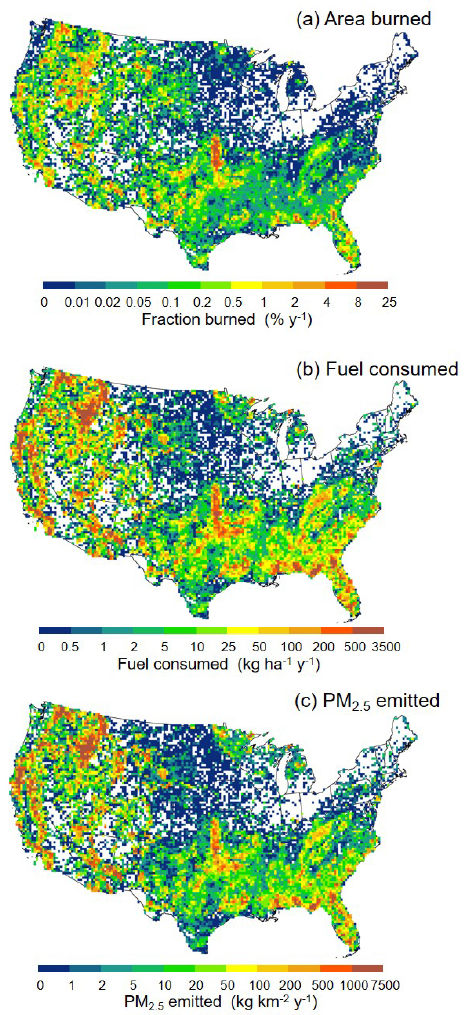
Figure 11. Annual burned area, fuel consumed, and PM 2 . 5 emitted averaged over